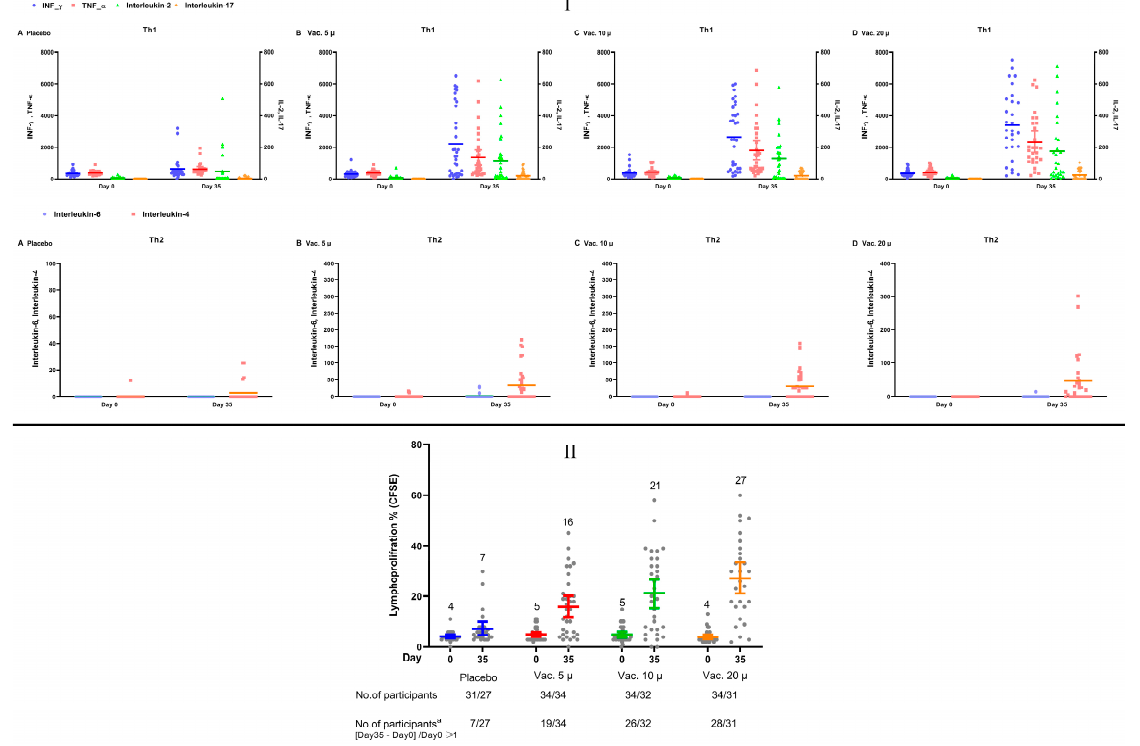
Figure 5. ( I) Scatter diagram of the ELISA levels (pg/mL) of IFN ɣ , TNF- α , IL-2, IL-17, IL-4, and IL-6 (comparing T-helper-1 and -2 pathways) in peripheral blood mononuclear cell (PBMC) extract following stimulation with the S antigen in the intervention groups on day 35 compared to the baseline. Geometric means have been shown on the diagram. ( II ) Scatter diagram of the percentage of lymphoproliferative response in peripheral blood mononuclear cell (PBMC) extract following stimulation with the S1 antigen and inactivated virus (CFSE) in the intervention groups on day 35 compared to the baseline percentage. Means, 95% confidence intervals, and the number of participants in each group with more than 100% change in the percentage of lymphoproliferative response from the baseline are shown in the diagram.